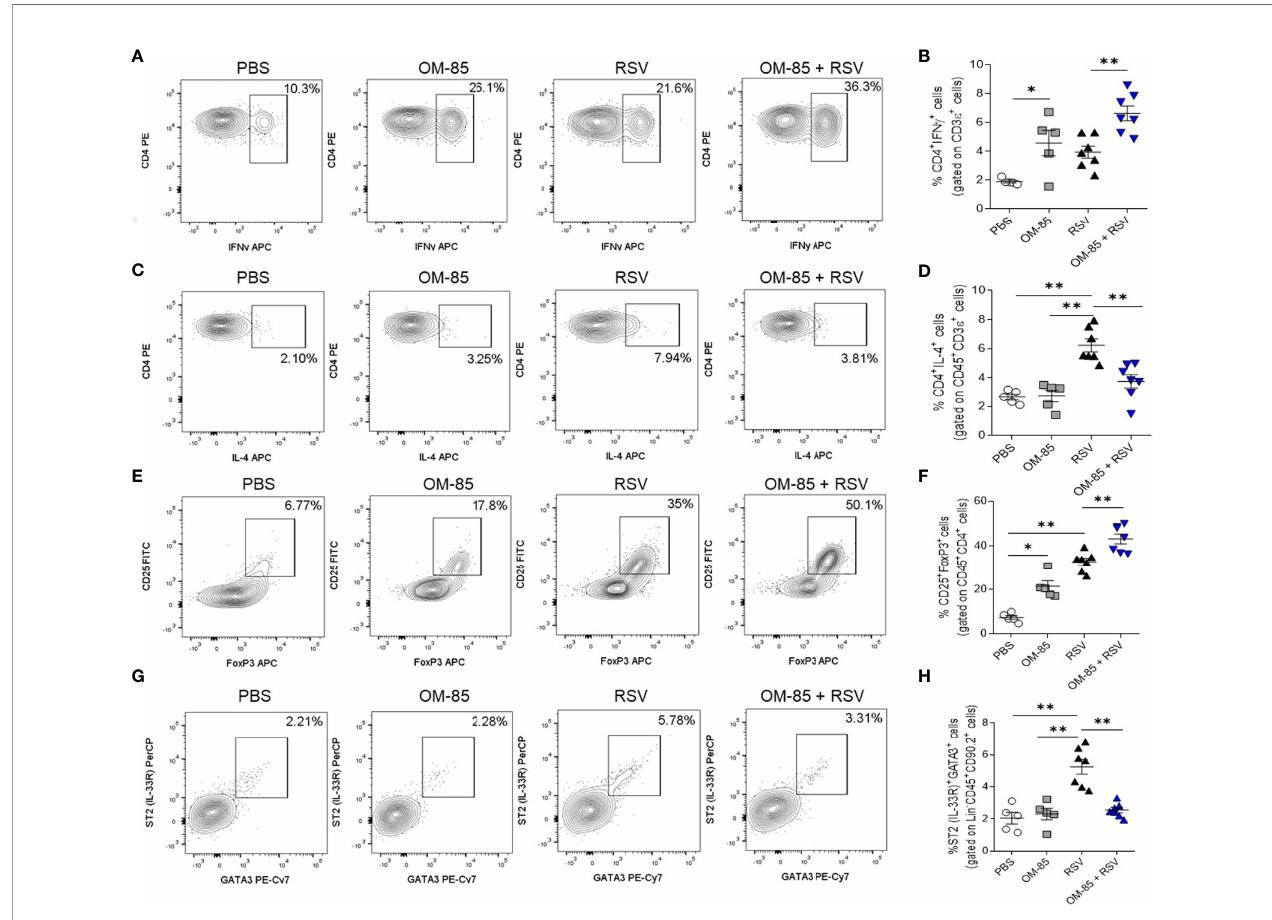
FIGURE 6 | Preventive treatment with OM – 85 modulates lymphocytes and lymphoid cell types in the lung in response to RSV infection. Mice were treated intranasally with OM – 85 (1mg) 5 days prior to RSV infection (four OM – 85 delivery). Afterwards, mice were infected with RSV (1x10 7 PFU/ml) and received another OM – 85 boost 6h later. BAL and lungs were harvested at day 5 post – infection. (A, B) Percentage of CD3 + CD4 + IFN g + Th1 cells in the lung and its representative FACS pro fi le. (C, D) Percentage of CD45 + CD3 + CD4 + IL – 4 + Th2 cells in the lung and its representative FACS pro fi le. (E, F) Percentage of CD45 + CD4 + CD25 + FoxP3 + Treg cells in the lung and its representative FACS pro fi le. (G, H) Percentage of Lineage – CD45 + CD90.2 + ST2 + Gata3 + ILC2 cells in the lung and its representative FACS pro fi le. All data are expressed as mean±SEM. Multiple groups were compared using Kruskal – Wallis. * p <0.05. ** p